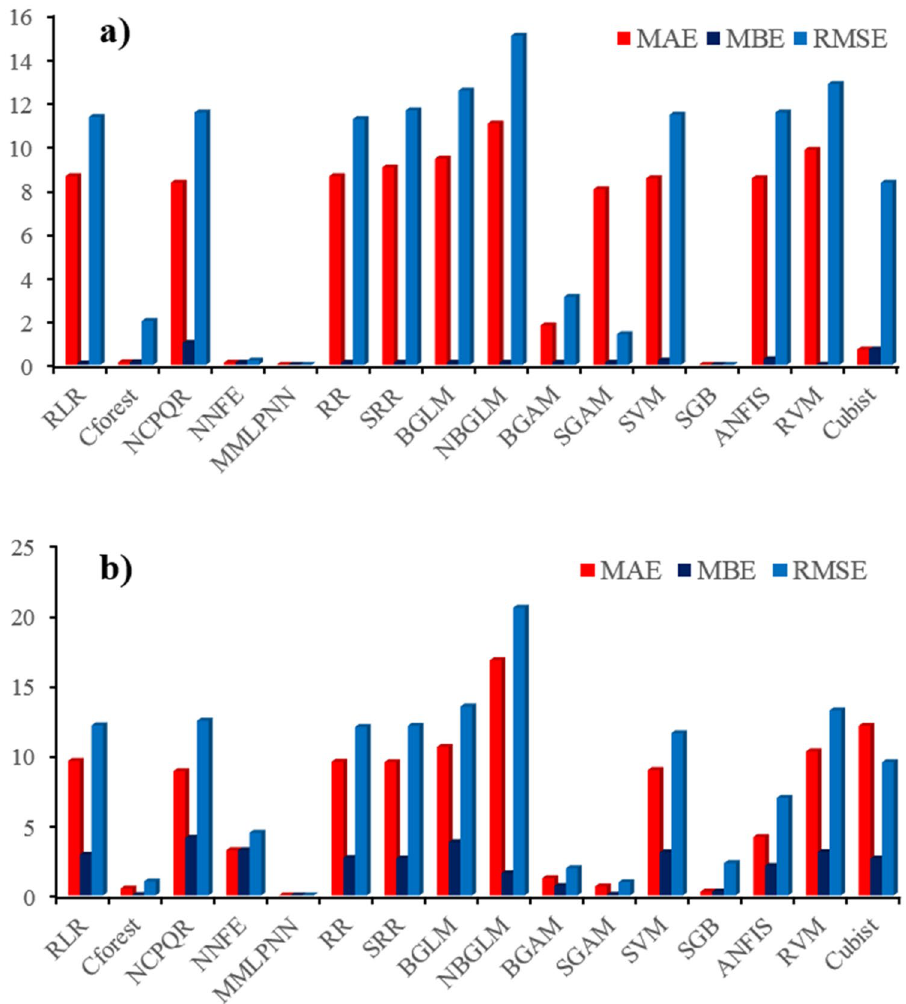
Figure 5. The values of the statistical indicators were used to evaluate model performance; (a) training dataset and (b) evaluation